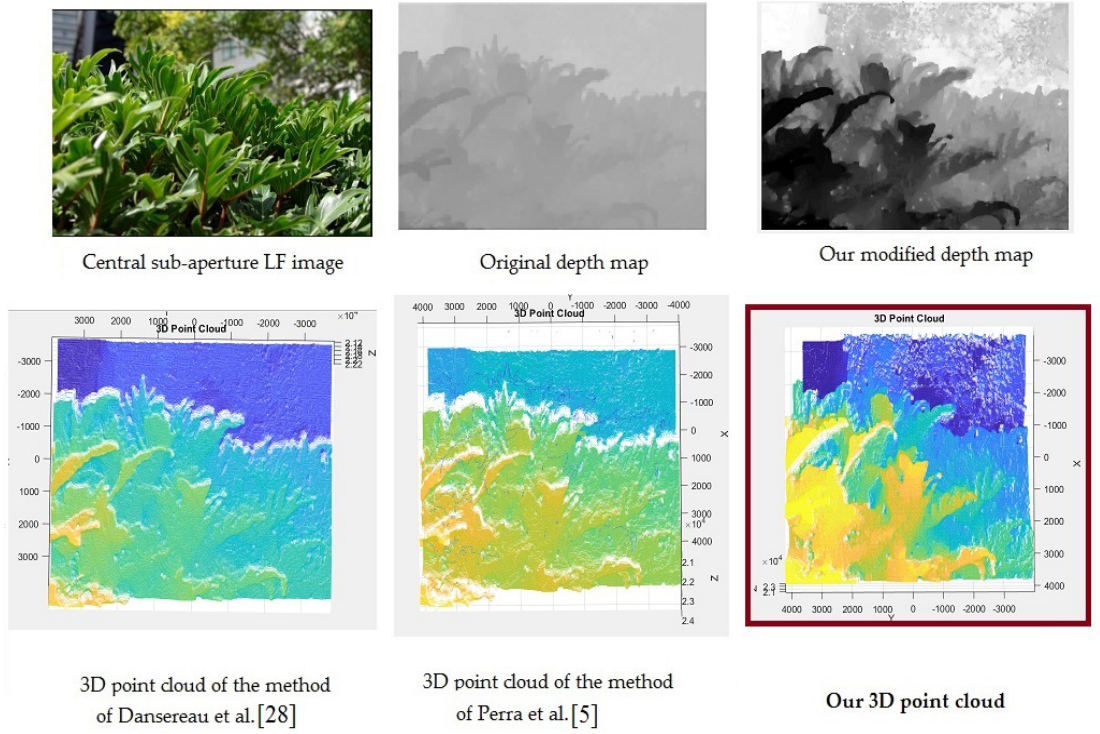
Figure 7. Comparing our result with other state-of-the-art methods. This input light field image is captured by ourselves with a Lytro Illum camera.